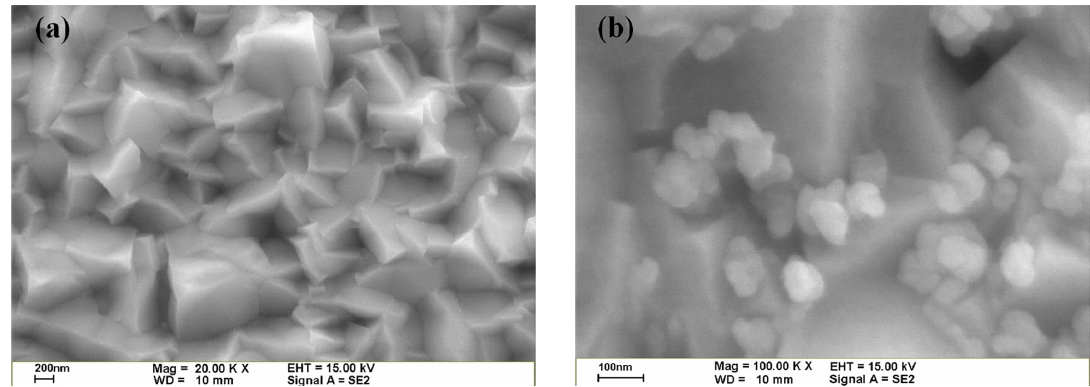
for 3 minutes, then (b) oxidized at 2